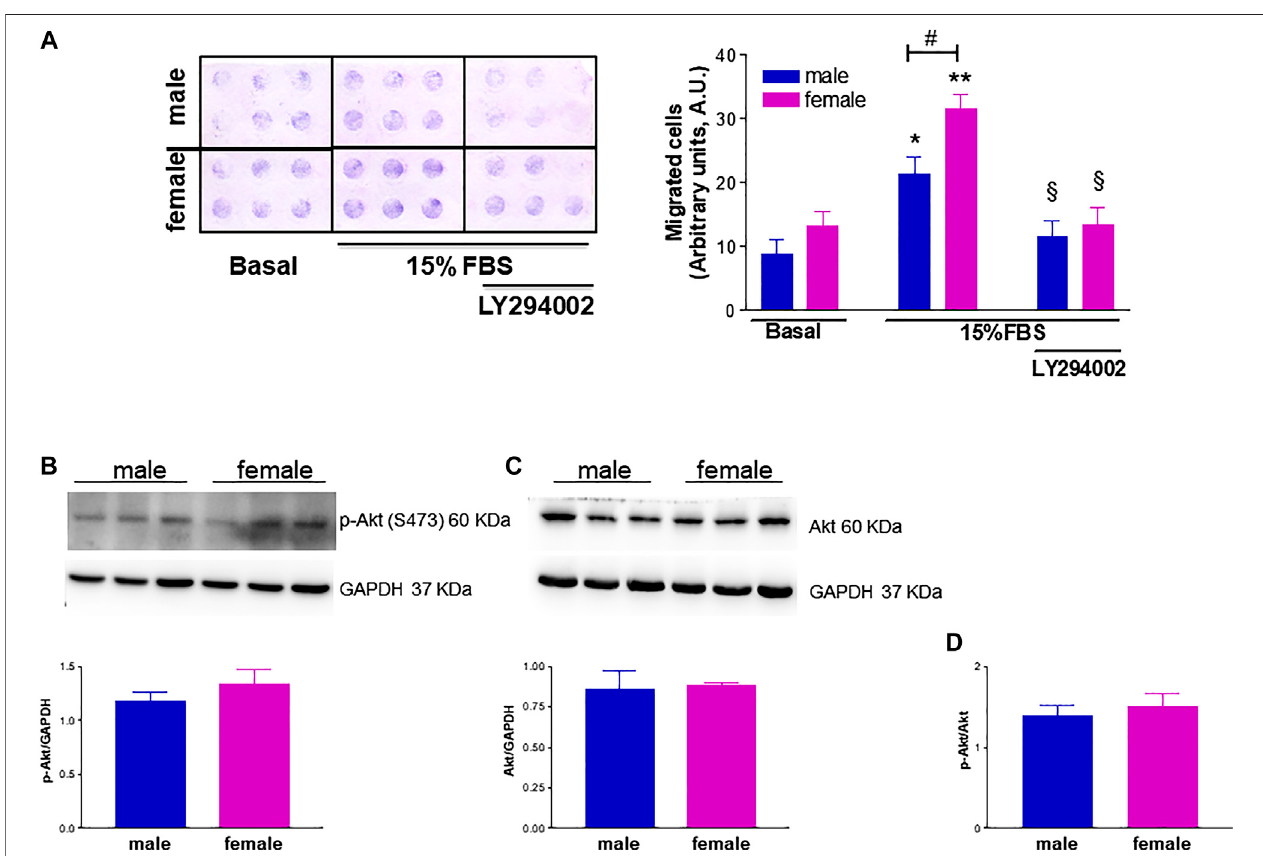
FIGURE 9 | Effect of phosphatidylinositol 3-kinase (PI3K) inhibition on FBS-induced HUVEC migration and effect of donor ’ s sex on Akt activation. (A) . The PI3K inhibitor LY294002 (25 µM) was tested in a chemotaxis assay on HUVECs from male and female donors using 15% FBS as a chemoattractant agent. Left panel: Representative image of HUVEC migration in a modi fi ed 48-well Boyden chamber after 6 h incubation at 37 ° C. Right panel: Cell migration is shown as optical density values (A.U., arbitrary units). Each independent experiment ( n (cid:1) 4) was performed in sextuplicate using cells from one male and one female donor. Data are expressed as mean ± SEM. t -test, * p < 0.05, ** p < 0.01 (vs. basal); # p < 0.05; § p < 0.05 (vs. 15% FBS alone). (B, C). HUVECs were seeded in 35-mm dishes in M199 complete medium. Upper panels: Representative Western blots showing the expression of p-Akt (S473) and total Akt, respectively; GAPDH was used as loading control. Lowerpanels: DensitometricanalysisofbandsnormalizedtoGAPDHlevels.Dataareshownasmean ± SEMofthreemaleandthreefemaledonors. (D) .p-Akt/ Akt ratio. t -test,